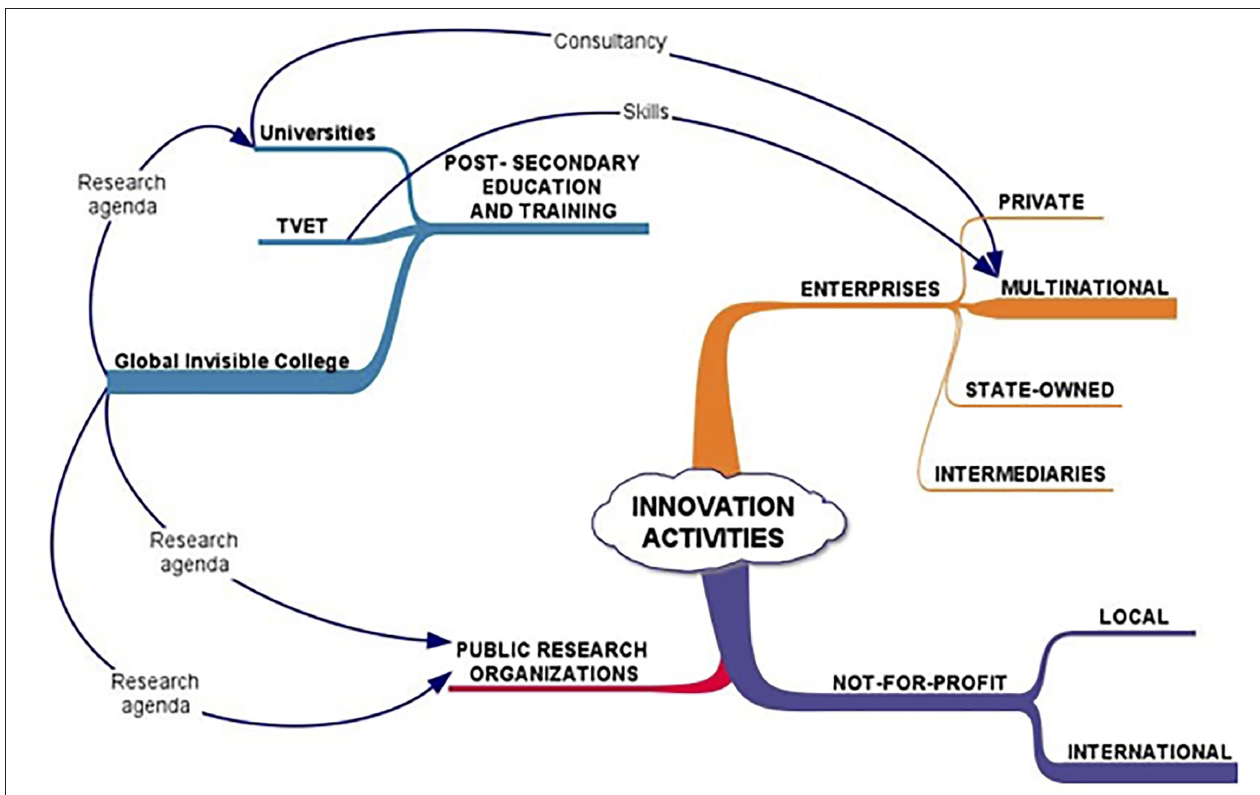
FIGURE 1 | A disarticulated innovation system. Source: